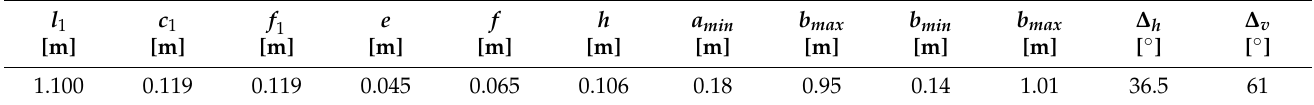
Table 1. Constant geometrical parameters of the HUBO scanner adopted for the